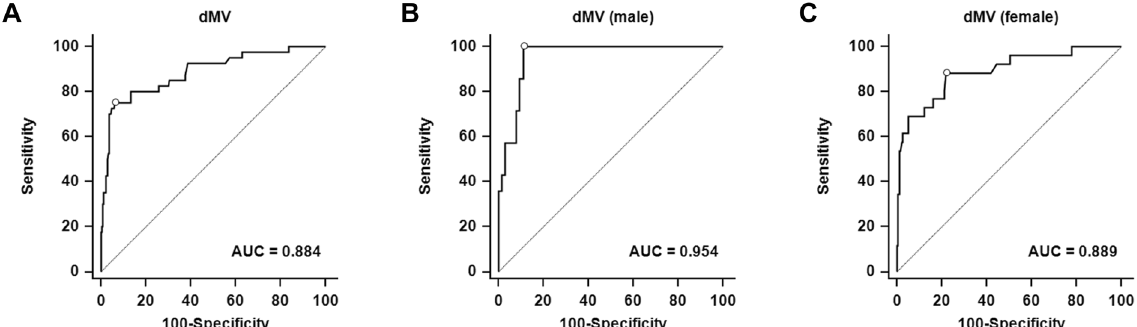
Figure 3. Receiver operating characteristic curves showing the ability of the membrane-to-vallecula distance (dMV) to predict difficult laryngoscopy . From left to right, the area under the curve for the dMV is 0.884 (95% CI 0.841–0.919) for both sexes ( A ), 0.954 (95% CI 0.880–0.988) in men ( B ) and 0.889 (95% CI 0.837–0.928) in women ( C ). The diagonal line indicates 50% discrimination and is provided to show how much each model improves on purely random assignment of the risk. CI indicates confidence